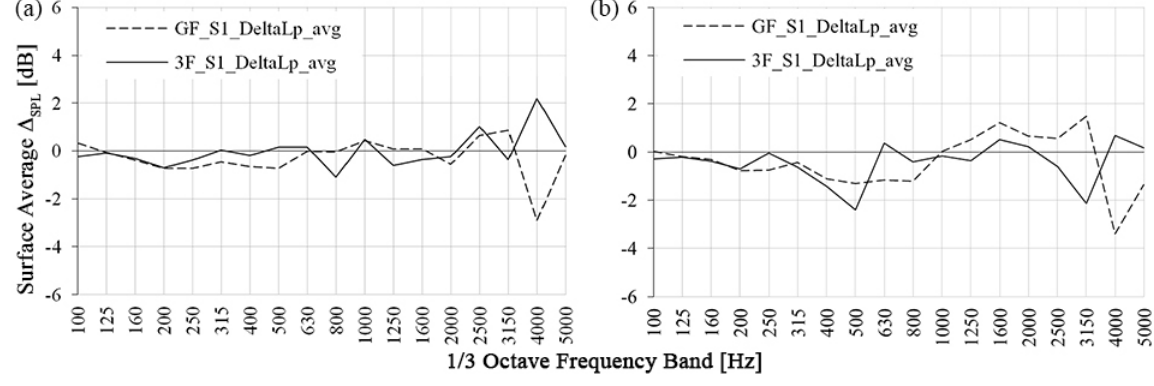
Figure 8. Δ SPL calculated between SPL on the glass surfaces of windows averaged over all the microphone positions. Ground floor (dashed line) and third floor (solid line). Source position in S1, as it is in Figure 4. ( a ) Δ SPL = A SPL − B1 SPL ; ( b ) Δ SPL = A SPL − B2 SPL . Configurations A, B1, B2 are as they are in Figure 3.